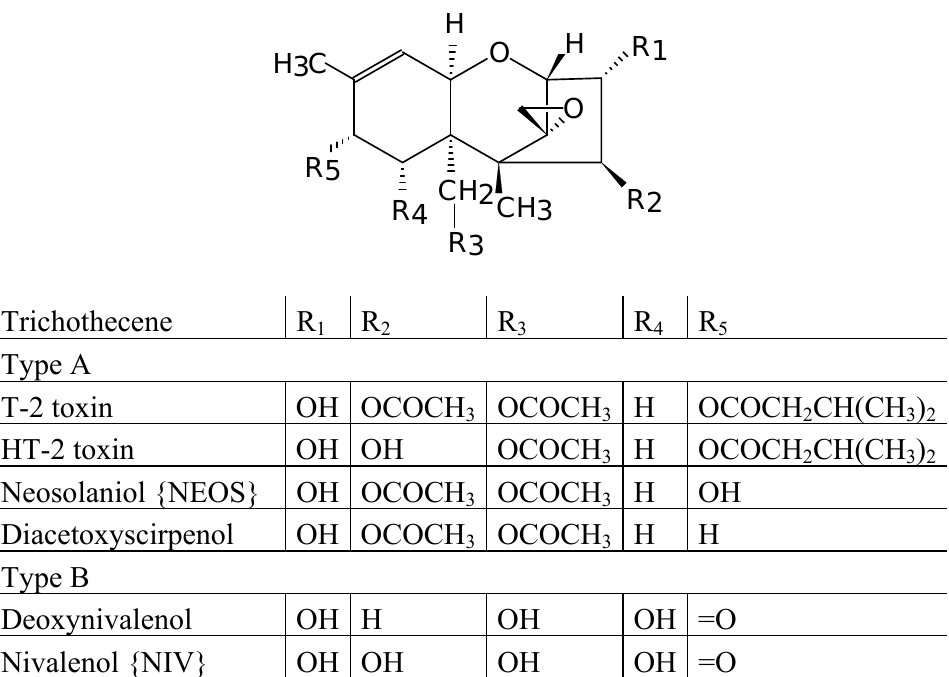
Figure 2. Structures of some important